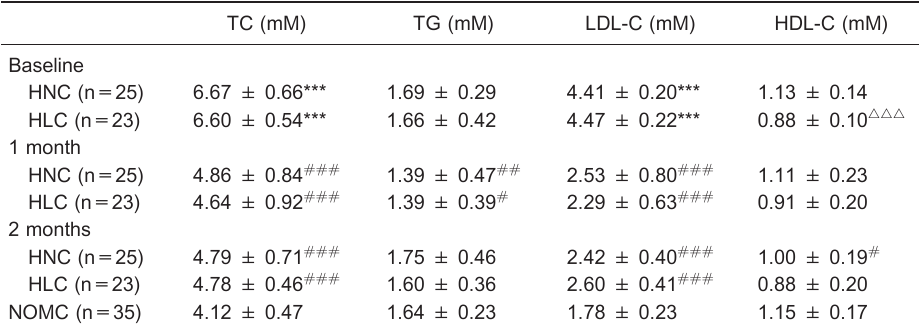
Table 2. Lipid profiles of atorvastatin-treated patients at baseline and after 1 and 2 months of